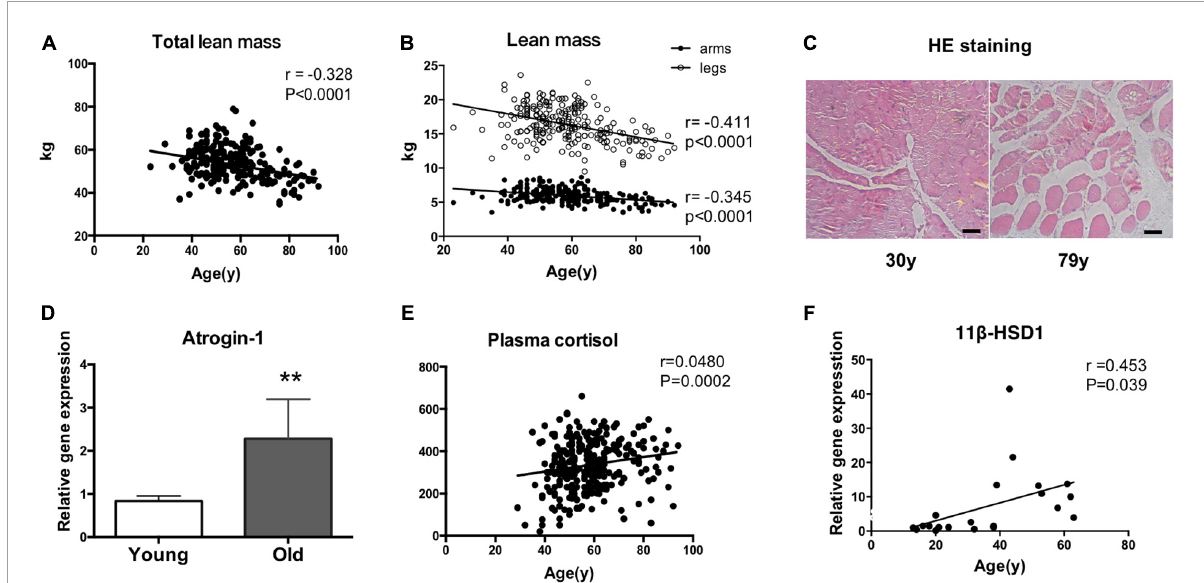
FIGURE1 11 β -HSD1 expression is up-regulated in human muscles with age-related atrophy. (A) Total and regional lean mass (arms and legs) were obtained from the DXA measurement. Total lean mass was negatively correlated with age ( r = –0.328, P < 0.0001). (B) With aging, the muscles of the lower limbs decline faster than those of the upper limbs (legs: r = –0.411, P < 0.0001; arms: r = –0.345, P < 0.0001). (C) Representative HE staining images of muscle fibers in a 79-year-old man and a 30-year-old man. Scale bars, 50 µ m. (D) RT–PCR assays were performed with vastus lateralis muscles obtained from young (aged < 30 years, n = 7) or old people (aged > 60 years, n = 8), and the results were normalized to GAPDH. ** p < 0.01. (E) Plasma cortisol levels were examined by ELISA in blood samples taken from recruited people ( n = 440). (F) The mRNA level of 11 β -HSD1 in vastus lateralis muscles was positively correlated with age ( r = 0453, p = 0.039) ( n = 20).